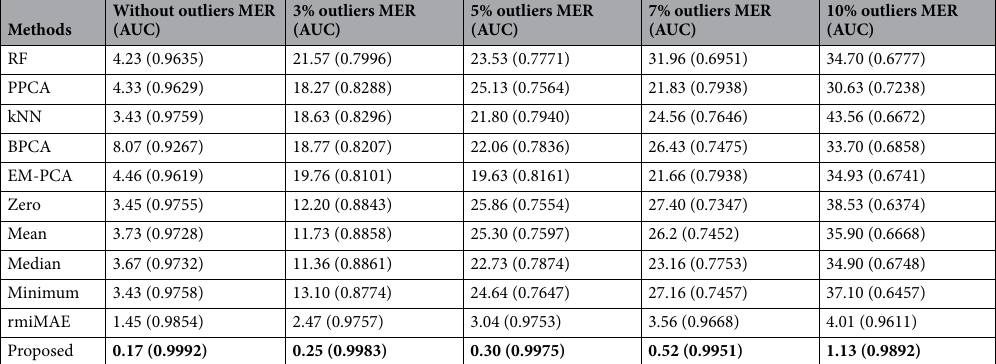
Table 5. Average misclassification error rate and area under the receiver operating characteristic curve (AUC) of sample classification for three class real dataset (MDA-MB-231) with 15.81% missing values and artificially imputed different rates of outliers. Bold indicates the lower MER and Higher AUC throughout the